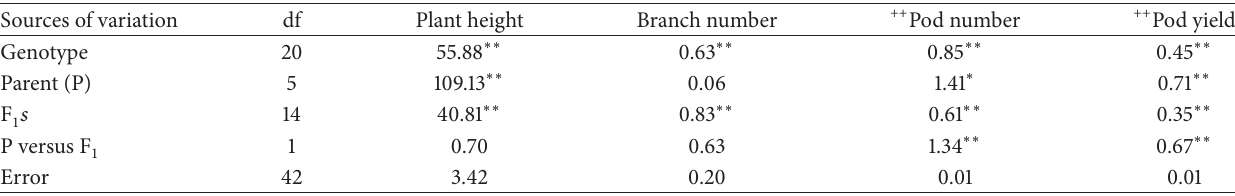
Table 3: Analysis of variance of pod yield and related traits in a 6 × 6 F 1 diallel population at 8 dS/m salinity imposed during flowering till harvest stages.